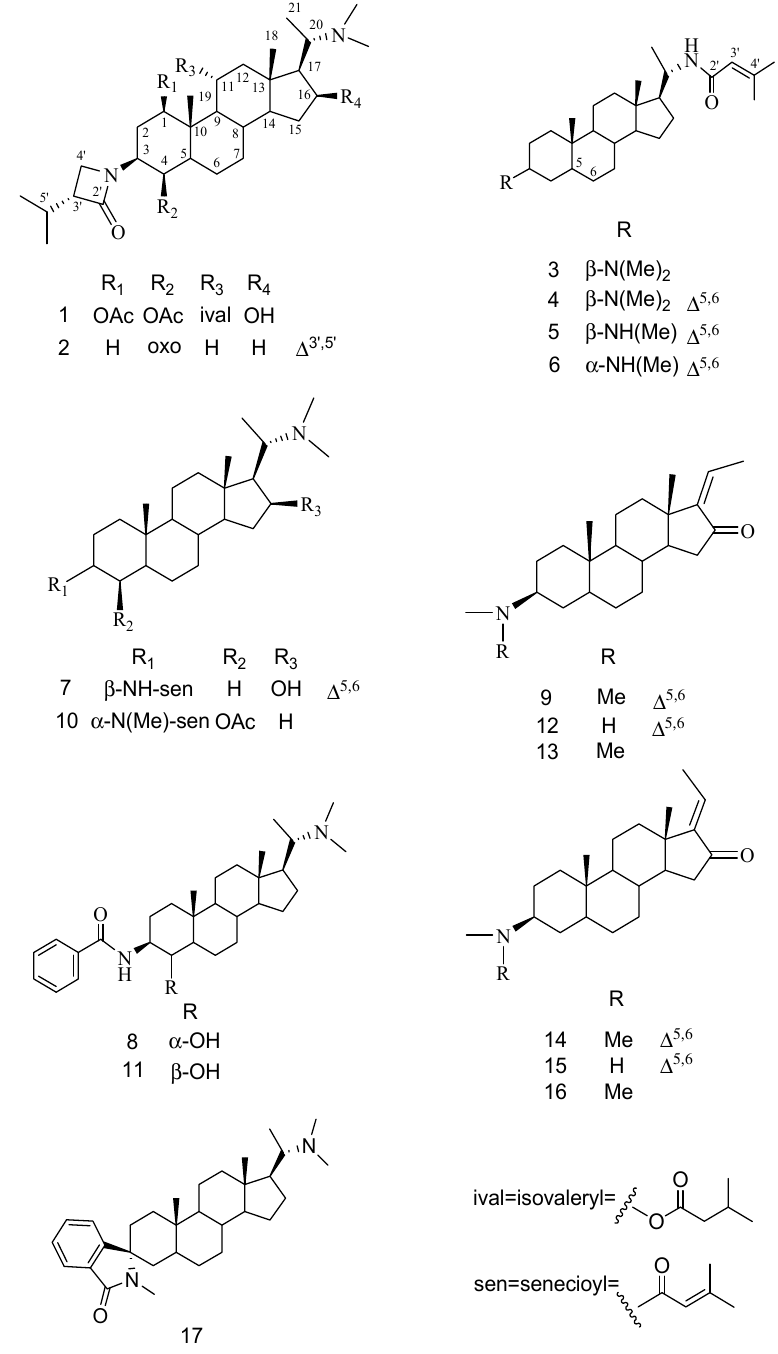
Figure 1. Structures of compounds 1 – 17 .